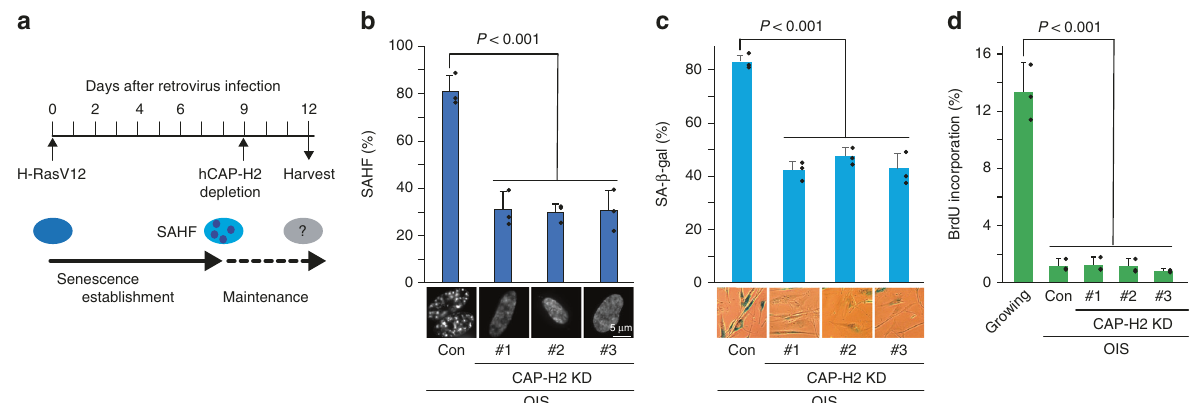
Fig. 7 Effects of CAP-H2 condensin depletion on senescence markers. a Schematic procedure to investigate effects of CAP-H2 condensin KD on the maintenance of OIS. IMR90 cells were infected with retrovirus encoding H-RasV12 and cultured for 9 days to establish OIS (Methods). OIS cells were then infected with lentivirus encoding one of the three shRNA constructs (#1, #2, and #3) against CAP-H2 gene ( NCAPH2 ) or carrying an empty vector (control) and harvested 3 days after the lentivirus infection. b – d Effect of CAP-H2 KD on maintenance of OIS. Cells prepared as in panel a were subjected to DAPI ( b ), SA- β -gal ( c ), and BrdU ( d ) staining. P -values were calculated by two-sided Student ’ s t -test, using biologically independent samples ( n = 3, error bars represent the